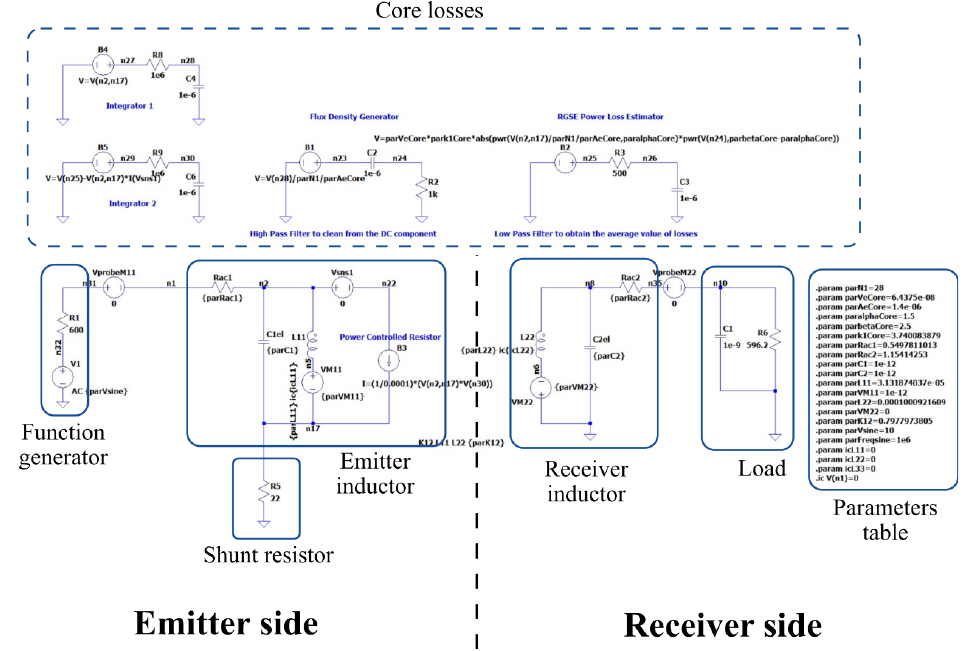
Figure 7. Equivalent circuit model for the frequency domain analysis.